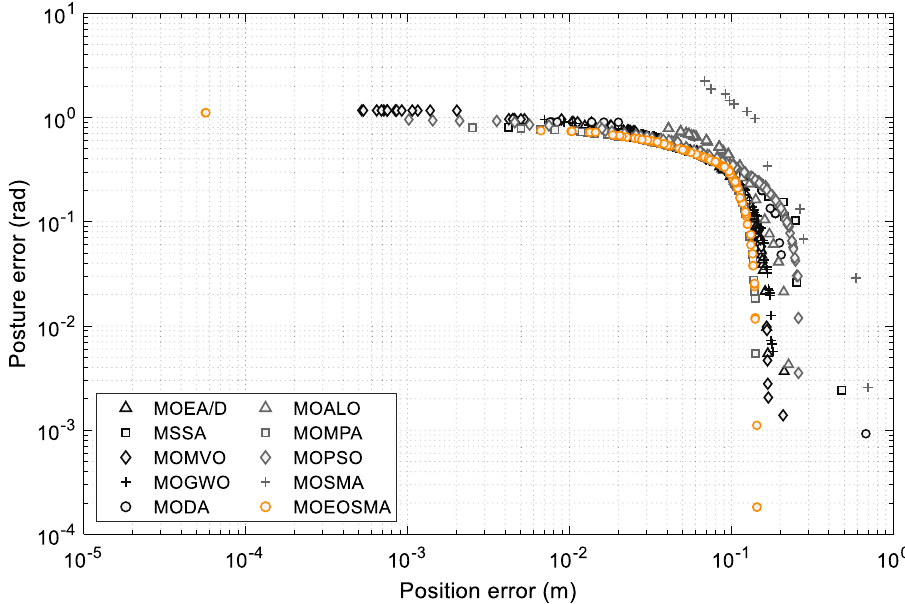
Figure 17. The PF obtained by multi-objective algorithms at desired pose P 1 .